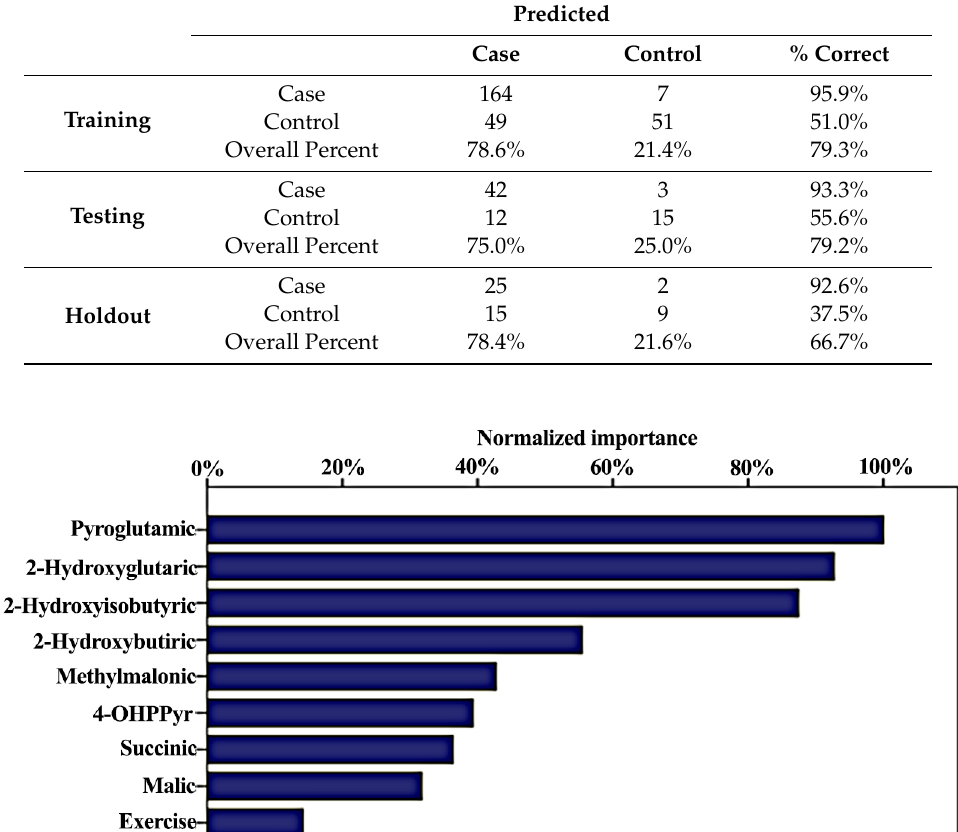
Table 4. Classification Table for Artificial Neural Network-Organic Acids.